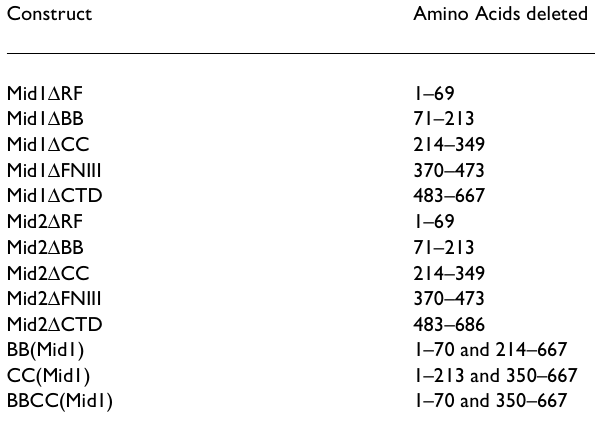
Table 1: The MID1 and MID2 deletion constructs used in pEGFP- C2 for cellular co-localisation analysis, co-immunoprecipitation and in pPC86/pDBLeu for interaction analysis with Alpha 4. Terms: RF denotes a C3HC4 RING finger; BB denotes C2H2 B- Boxes; CC denotes a Coiled-coil motif; FNIII denotes a Fibronec- tin Type III domain and CTD denotes a C-terminal domain (en- compassing a SPRY